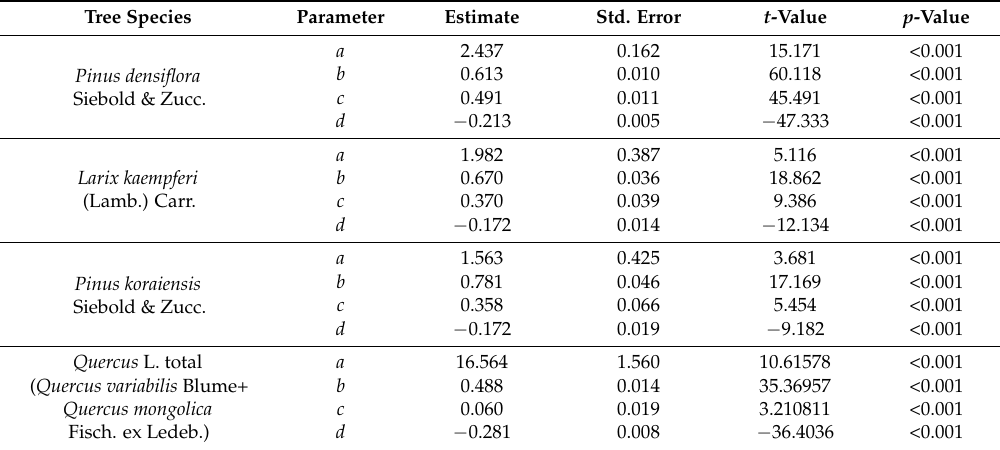
Table 3. Coefficient and significance level for the major tree species estimated from Equation (1). Tree